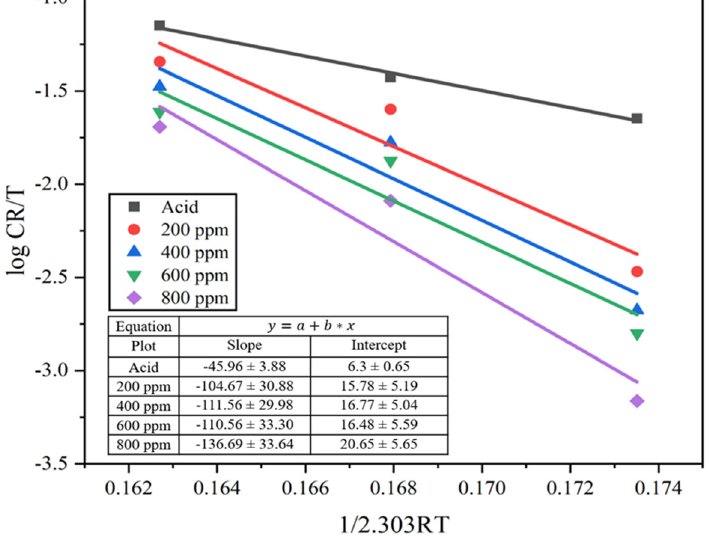
Figure 10. Transition state plot for the MS sample in 1M H 2 SO 4 and different concentrations of the inhibitor solutions. inhibitor